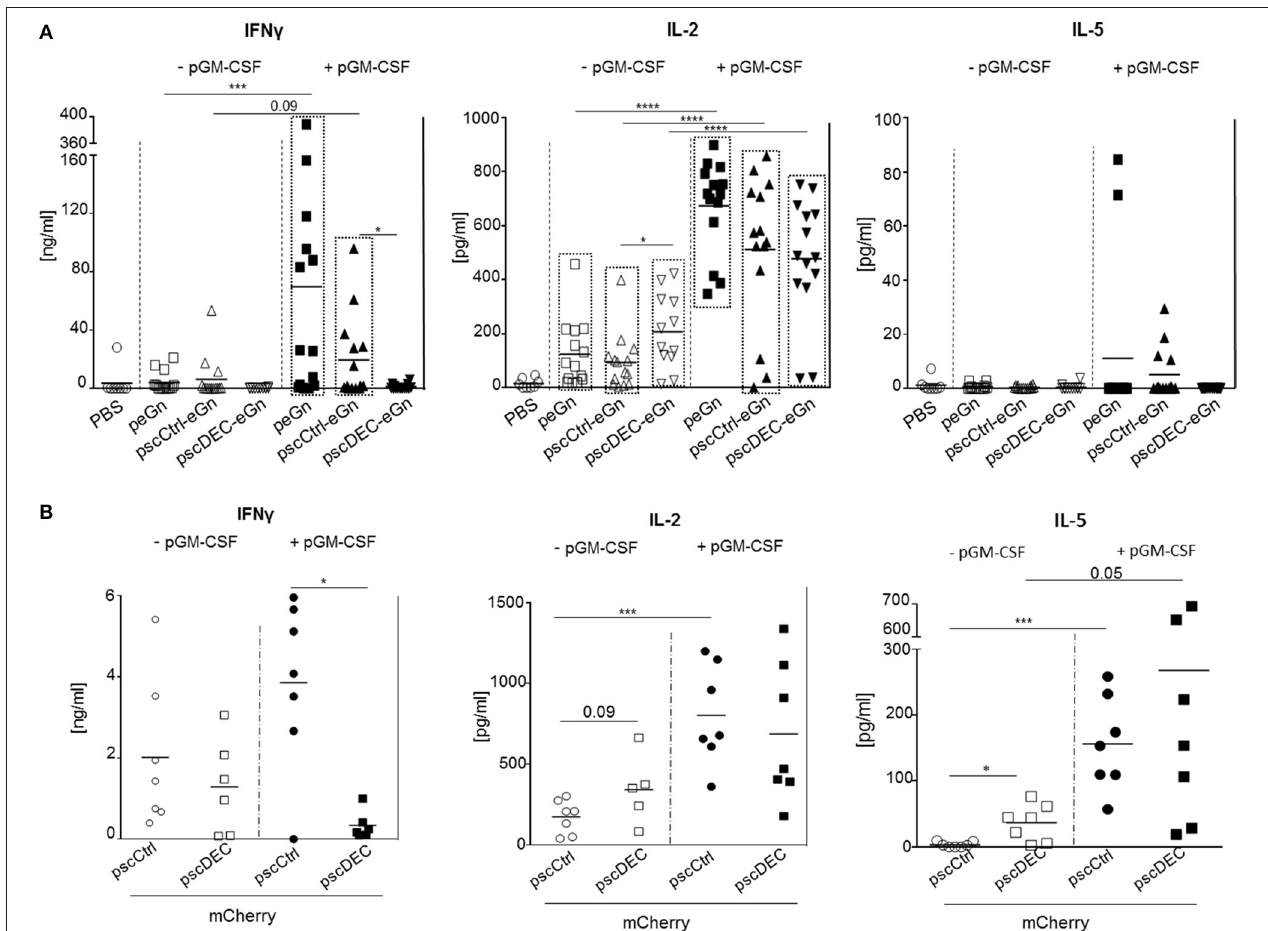
FIGURE 4 | T cell responses induced by eGn and mCherry encoding plasmids. (A) The spleen cells were collected from mice (7 per groups) immunized with scDEC205-eGn, scCtlr-eGn, and eGn ( ± pGM-CSF), 3 weeks after the last immunization (day 60). Splenocytes (2 × 10 6 cells per well) were re-stimulated in vitro with overlapping eGn peptides covering the N-terminal and C-terminal parts (5 µ g/ml) or with an irrelevant peptide (5 µ g/ml). IFN γ , IL-2, and IL-5 concentration were measured from cell culture supernatants at 72h after the stimulation. The specific cytokine secretion was obtained using the signal from irrelevant peptide wells subtracted from conditions with specific eGn peptides covering the N-terminal or C-terminal parts. The total T cell responses per mouse was calculated by adding the cytokine concentrations obtained with the 2 peptide pools. Each symbol represents an individual animal and the mean is indicated ( n = 5–7 per group). P -values were determined according to the Mann–Whitney test (* p < 0.05; *** p < 0.001; **** p < 0.0001). The significant differences between the cytokine levels of the PBS vs. the immunized groups is indicated by a box for clarity ( p < 0.05). This experiment has been done twice with the same results. (B) Splenocytes (2 × 10 6 cells per well) from the mice of the experiment described in this figure were collected at D60 and re-stimulated in vitro with overlapping mCherry peptides (5 µ g/ml) or with an irrelevant peptide (5 µ g/ml). IFN γ , IL-2, and IL-5 concentration were measured from cell culture supernatants at 72h after the stimulation. The specific cytokine secretion was obtained from irrelevant peptides wells subtracted from condition with specific mCherry peptides. Each symbol represents an individual animal and the mean is indicated ( n = 7 per group). This experiment with pGM-CSF has been done twice with the same results. P- values were determined according to the Mann–Whitney test (* p < 0.05; *** p <